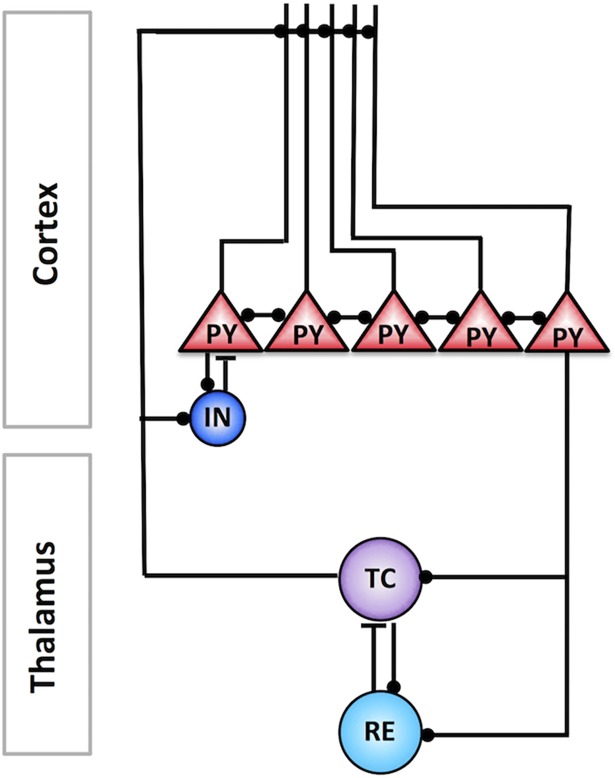
The schematic of the thalamocortical network model.The cortical layer was organized in a one-dimensional chain of pyramidal cells (PYs) and inhibitory neurons (INs). The thalamus model included thalamic relay (TC) and reticular thalamic (RE) neurons. Black filled circles and black bars represent excitatory and inhibitory connections between neurons, respectively.